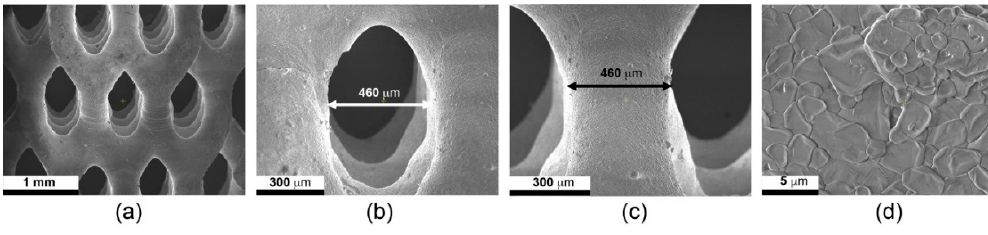
Figure 11. SEM images of the BI004 implant after sintering: ( a ) scaffold; ( b ) enlarged view of a pore; ( c ) enlarged view of a rib; ( d ) sintered ceramics.